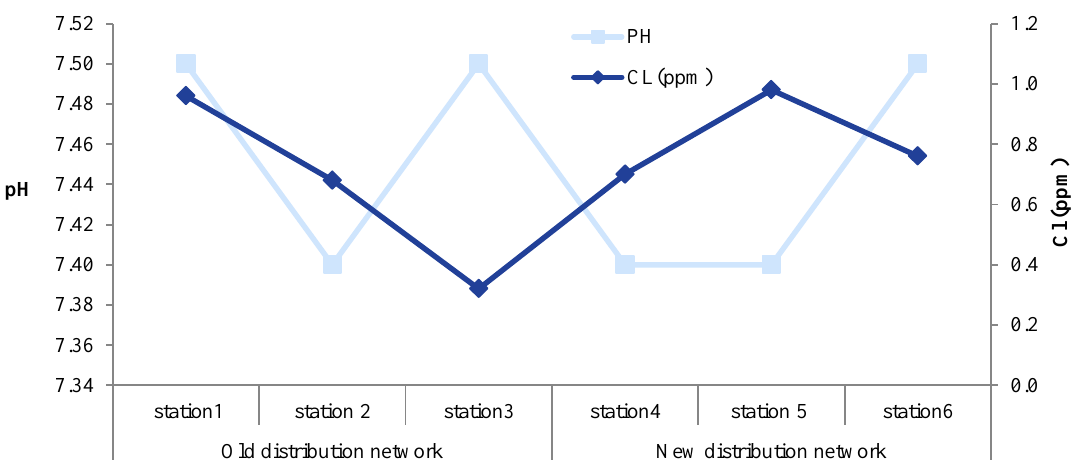
Figure 3. Temporal trends in the average of chlorine (Cl) and pH of the water distribution system during the study period in Aradan